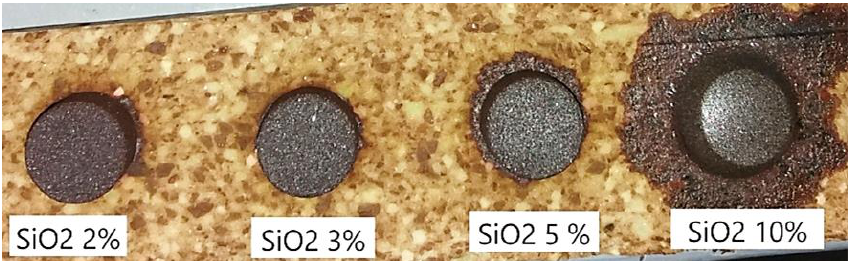
2 O 3 addition after calcination.